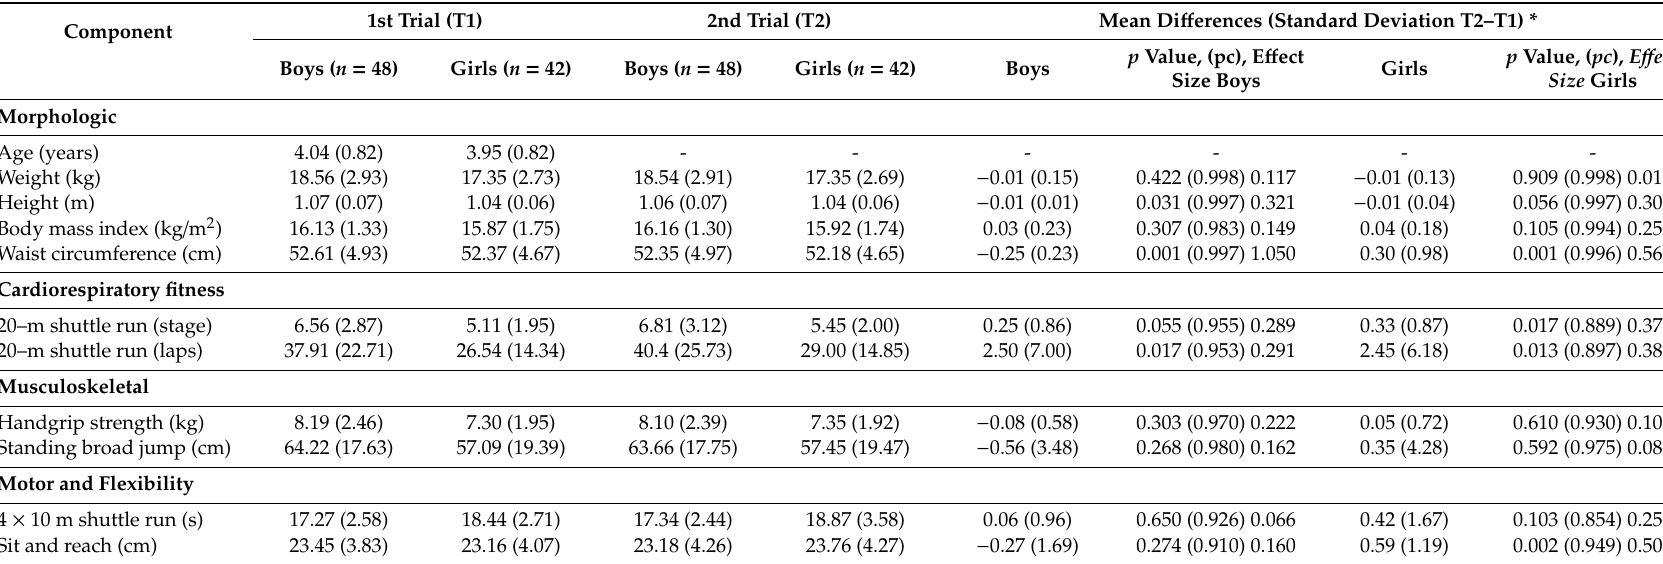
Table 2. Test (T1), retest (T2), mean di ff erences (T2–T1), and concordance correlation coe ffi cient (pc) of “Fuprecol kids” battery, by